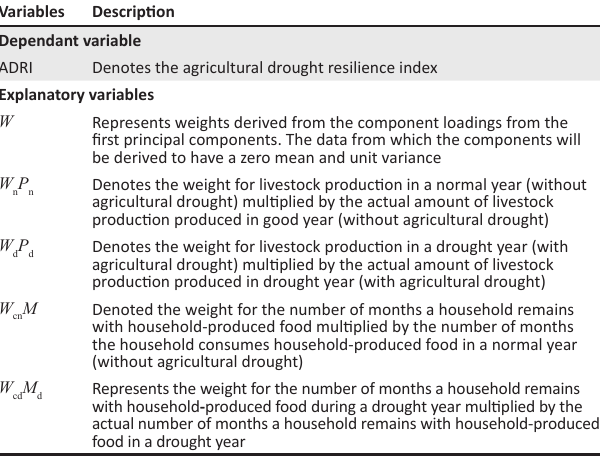
TABLE 2: Description variables as dependent and independent in Equation